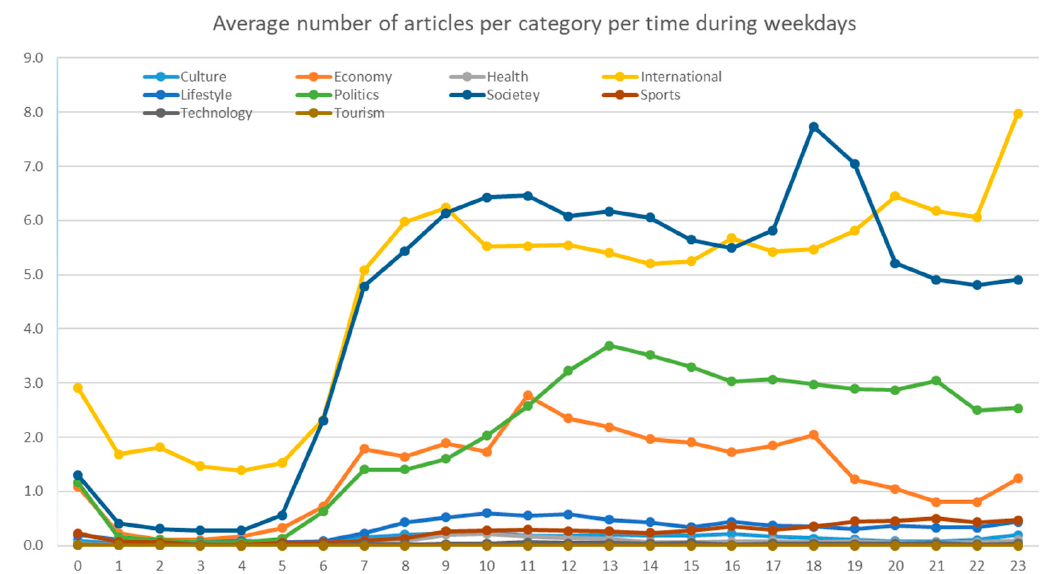
Figure 8. Average number of articles per category per hour during weekdays.